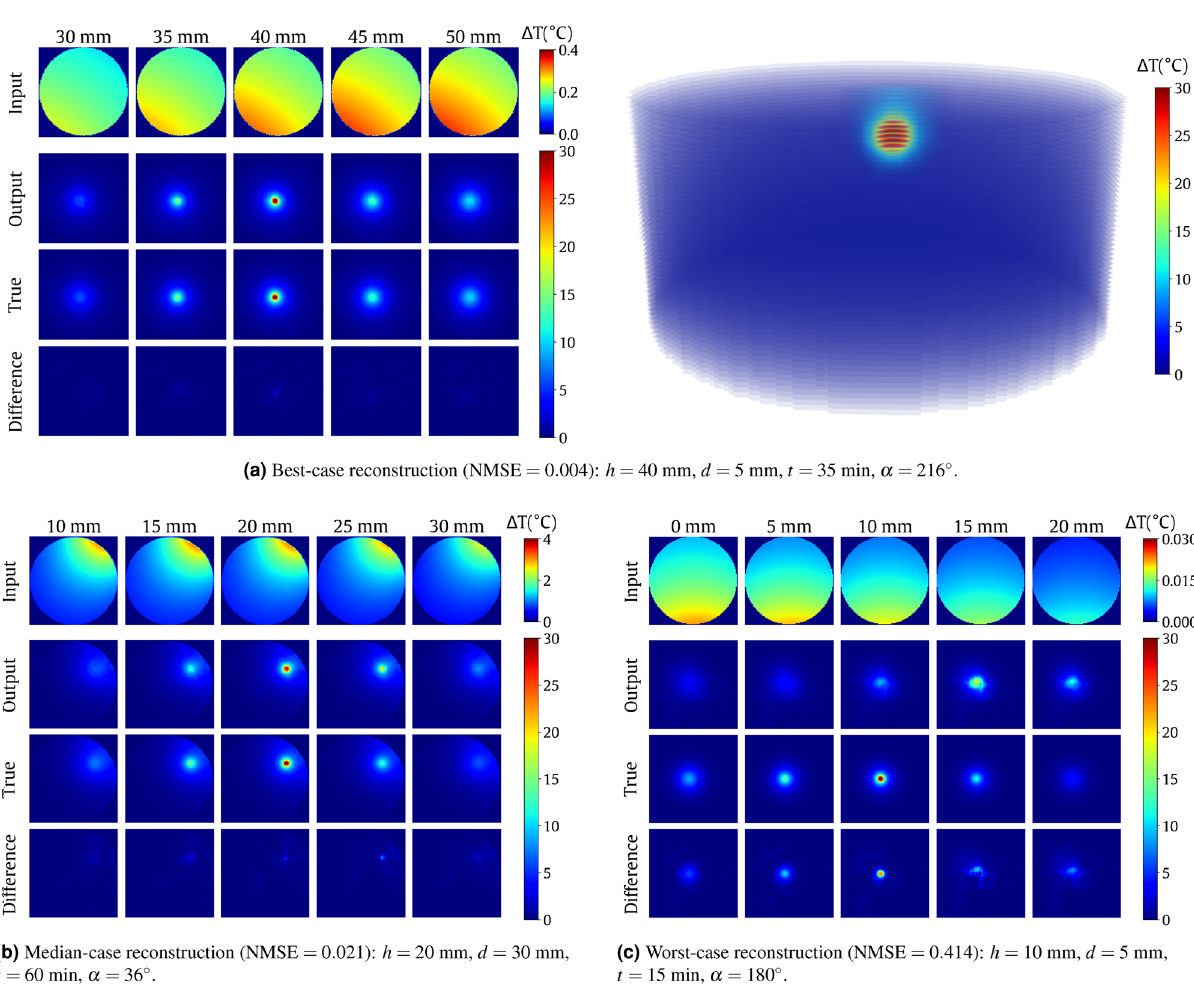
Figure 5. Visualization of the reconstruction results. Top to bottom in each subplot with projections: backprojection slices, final tomographic reconstruction slices, ground-truth slices, the difference between the reconstruction and ground truth (reconstruction error). In each case, the central column contains the heat source center. The location (height) of each slice is given above the column. Volumetric visualization of the reconstruction outcome is given in ( a ) (see Supplementary Video